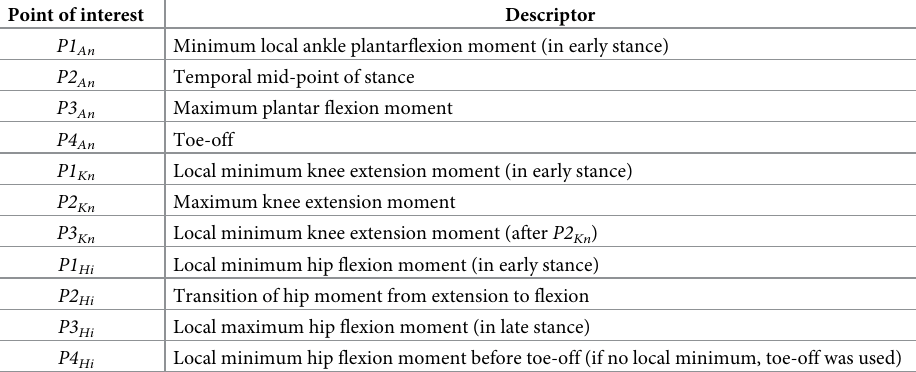
late dorsi-flexion phase for that trial. Fig 1 visualizes the points of interest and quasi-stiffness phases for the ankle. Knee. For the knee, we defined the 3 points of interest as the: local minimum knee exten- sion moment at the beginning of stance ( P1 ), maximum knee extension moment ( P2 ), Kn Kn and local minimum knee extension moment occurring after P2 ( P3 ). We calculated the Kn Kn quasi-stiffness phases of knee flexion (K ) and knee extension (K ) between P1 and KnF KnE Kn , and P2 and P3 respectively. The points of interest and quasi-stiffness phases of the P2 Kn Kn Kn knee are displayed in Fig 2. Hip. The hip moment-angle relationship had 4 points of interest: local minimum hip flex- ion moment at the beginning of stance ( P1 ), when the hip moment transitioned from exten- Hi sion to flexion ( P2 ), local maximum hip flexion moment occurring near the end of stance Hi ( P3 ), and local minimum hip flexion moment before toe-off, or if there was no local mini- Hi mum, toe-off ( P4 ). At normal to fast speeds (1.2 & 1.6 m/s) in normal gravity, the transition Hi of hip moment from extension to flexion coincided with a local maximum hip flexion moment before the temporal mid-point of stance. We defined the 3 consecutive quasi-stiffness phases of the hip as: early extension (K ) between P1 and P2 , late extension (K ) between HiE1 HiE2 Hi Hi and P3 , and flexion (K ) between P3 and P4 . Between P1 and P3 , we defined a P2 HiF Hi Hi Hi Hi Hi Hi 4 th phase of quasi-stiffness (K ) encapsulating the total phase of hip extension. In trials HiE where the hip moment did not transition from extension to flexion, we did not calculate K HiE1 Table 2. All points of interest for finding quasi-stiffness phases and their description. Point of interest Descriptor P1 An Temporal mid-point of